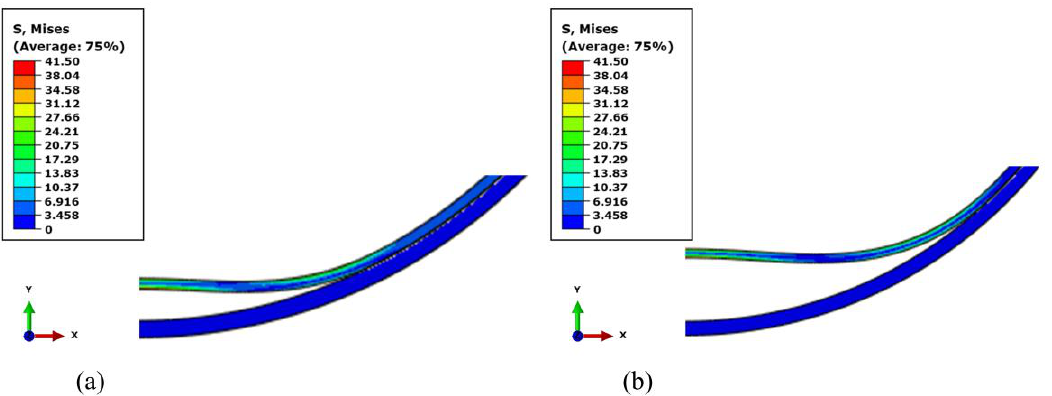
Figure 12. The stress distribution of ( a ) Sample B-2; ( b ) Sample C-6 under the critical buckling pressure.